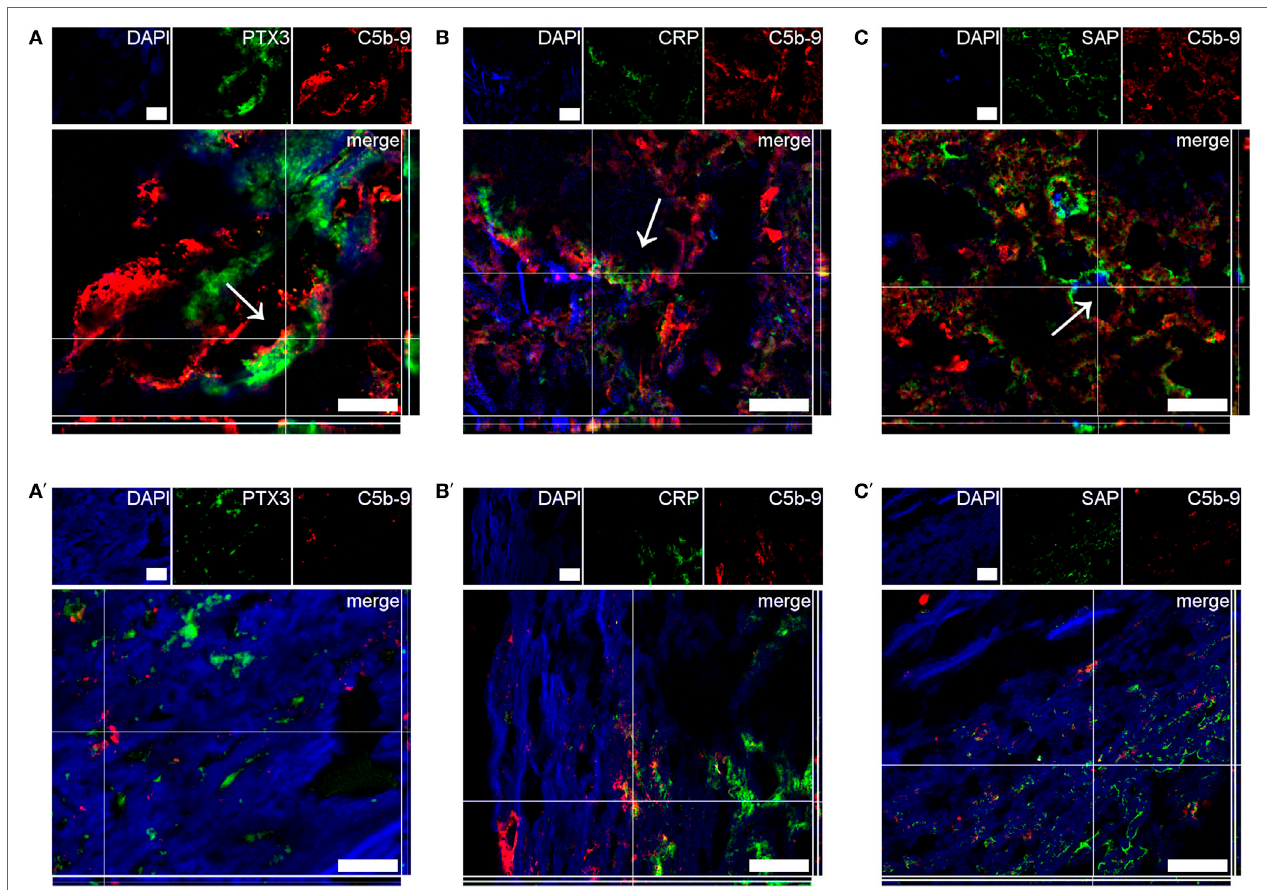
FigUre 7 | High magnification confocal images showing co-localization of pentraxin 3 (PTX3) (a,a ′ ) , C-reactive protein (CRP) (B,B ′ ) , and SAP (c,c ′ ) with C5b-9 in human atherosclerotic plaques . In the necrotic core (a–c) , PTX3, CRP, and SAP (green) surrounded black areas (arrows) likely corresponding to cholesterol clefts, and partially co-localized with C5b-9 (red). In the tunica media (a ′ –c ′ ) , PTX3, CRP, and SAP were present to a lesser extent than in the necrotic core, and showed scarce co-localization with C5b-9. Images in (a ′ –c ′ ) showed the specific signal for each of the proteins obtained after deletion of the collagen-associated unselective fluorescence typical of the tunica media. Images are representative of four plaques analyzed per marker. Scale bars = 20